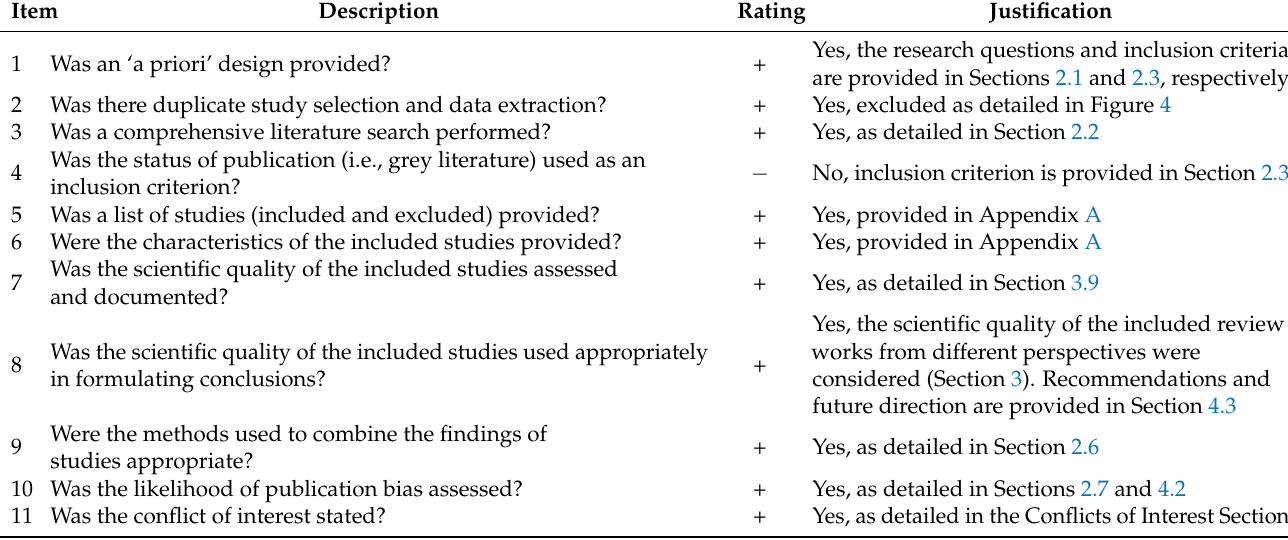
Table 2. Study assessment on this umbrella review using AMSTAR appraisal